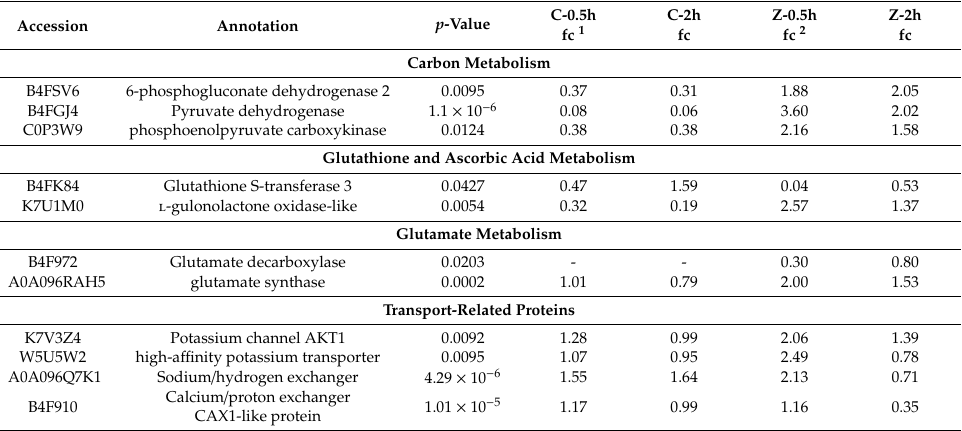
Table 1. Details of di ff erentially regulated phosphoproteins related to salt tolerance in Zheng58 roots. Accession Annotation p -Value